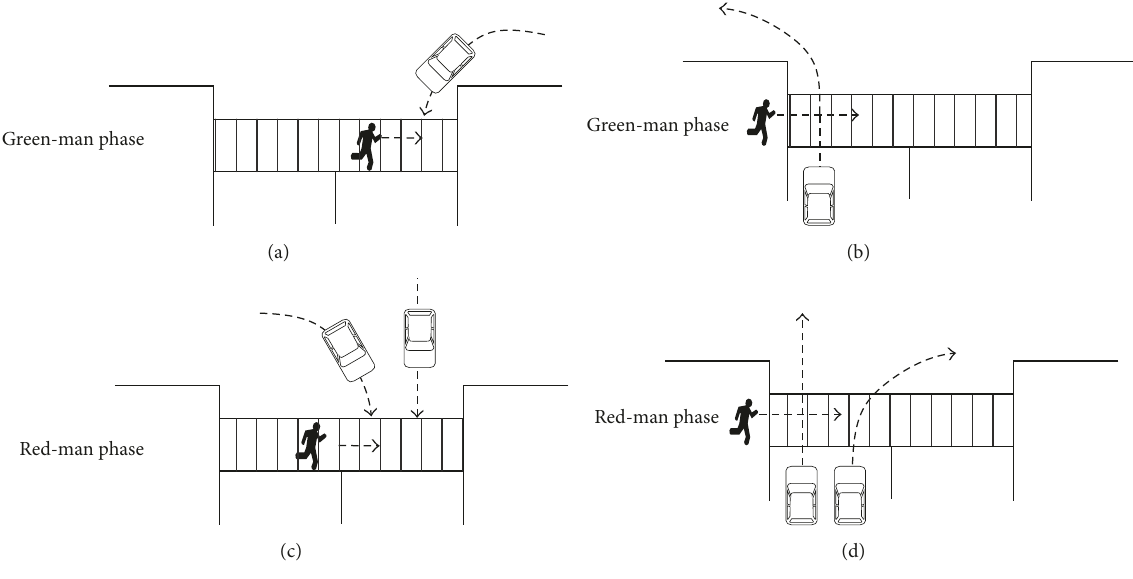
Figure 5: Conflict areas at pedestrian